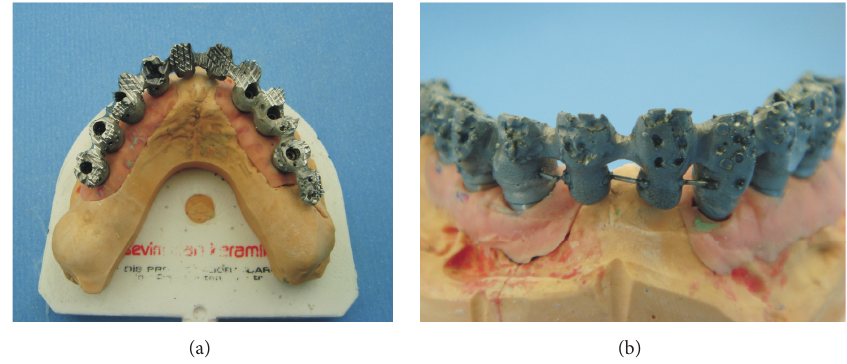
Figure 6: (a) Occlusal and (b) frontal view of laser sintered metal substructure.